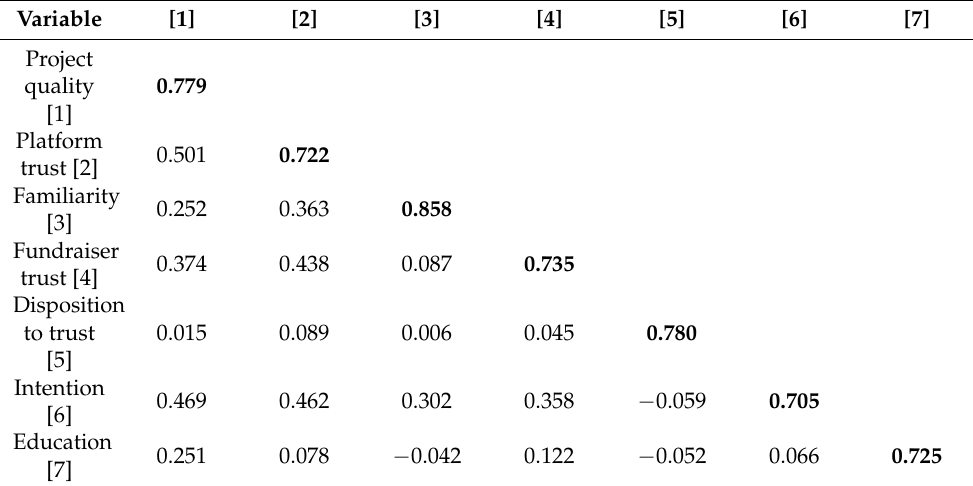
Table 4. Comparison of the square root of AVE to correlations for each variable pair.